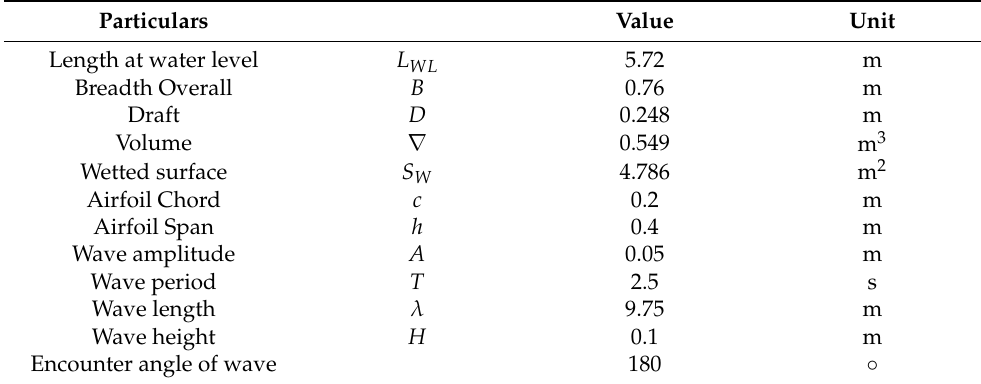
Figure 1. Frames of reference and sketch of the relationship between hull, flapping foil, and wave. Table 1. Main particulars of DTMB 5415, NACA 0012 airfoil model, and waves.